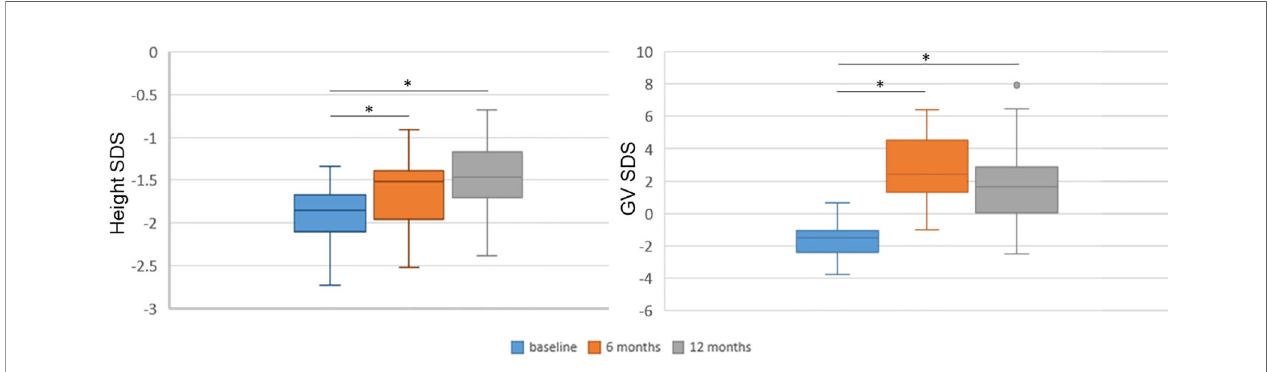
FIGURE 2 | Height and growth velocity over time. Height and growth velocity are represented with respect to the previous 6 months. Height and growth velocity (GV) were standardized according to Tanner ’ s standards. SDS, standard deviation score. * p < 0.0001 versus baseline at paired Student ’ s t